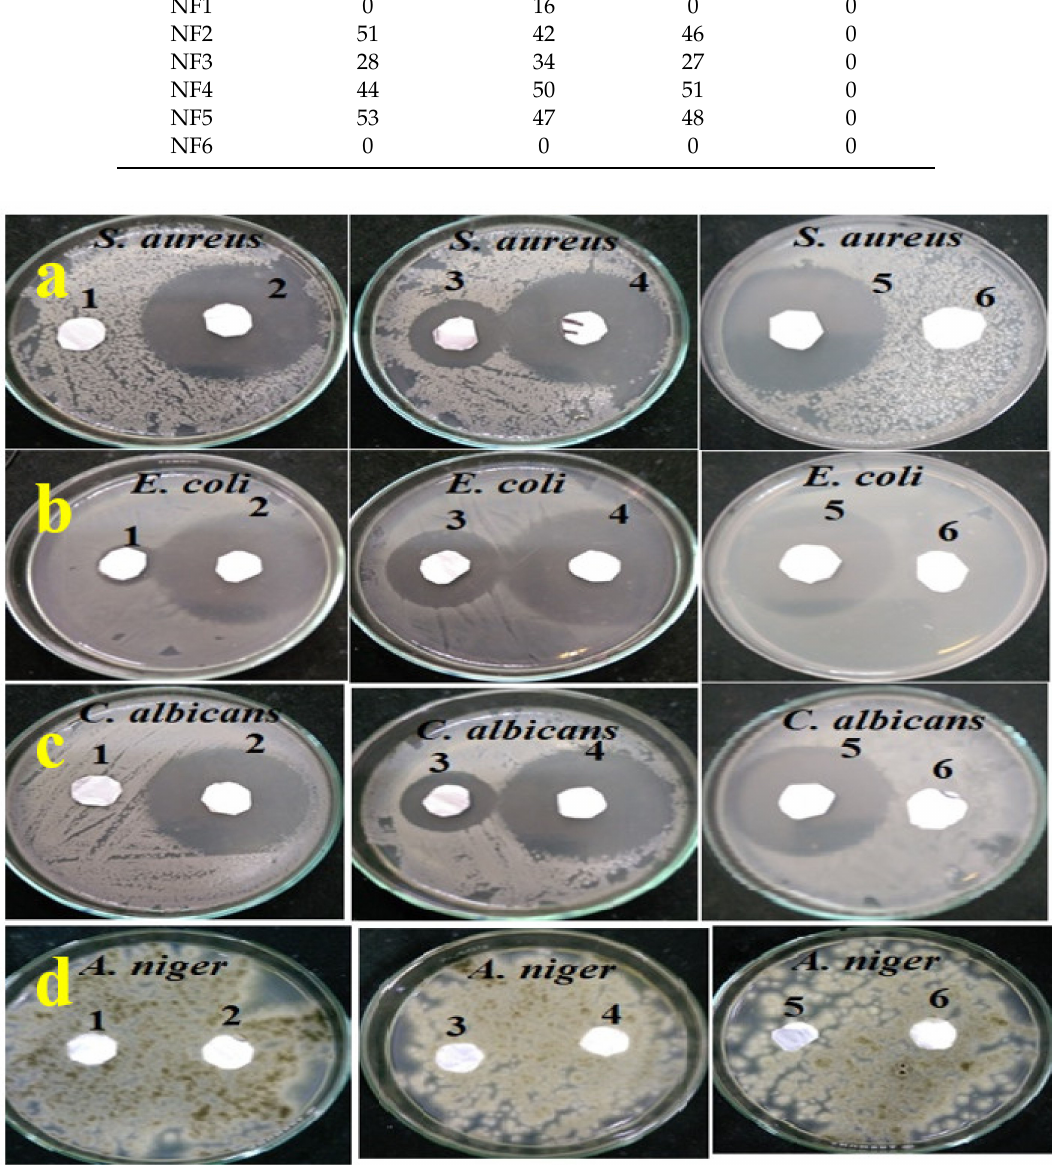
Figure 8. Antimicrobial activity using disc di ff usion method for nanoformulated fibers towards ( a ) S. aureus , ( b ) E. coli , ( c ) C. albicans , and ( d ) A.